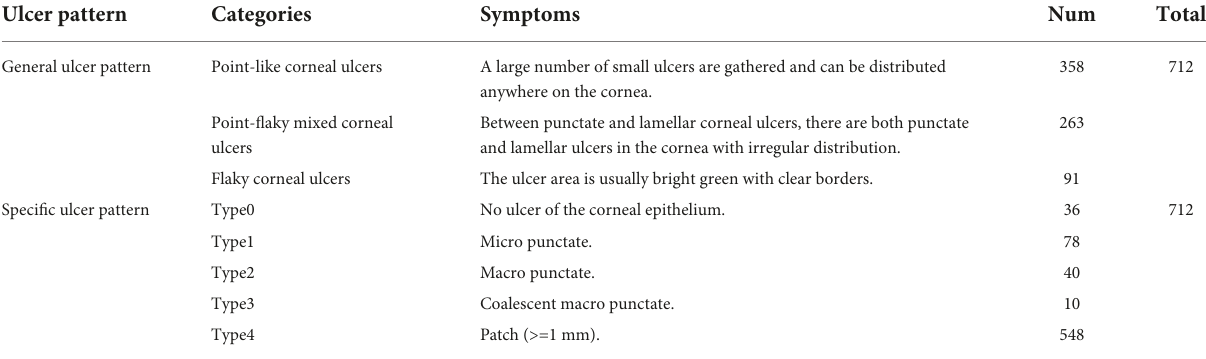
TABLE 1 Symptoms and number of different types of corneal ulcers. Ulcer pattern Categories Symptoms Num Total General ulcer pattern Point-like corneal ulcers